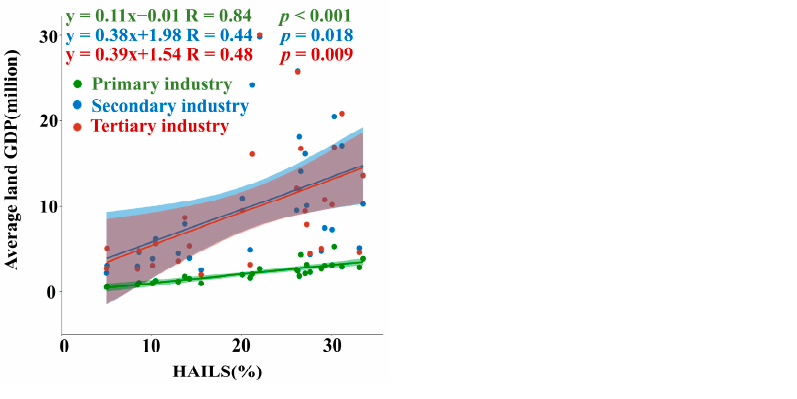
Figure 7. Correlation between average land GDP of primary industry, secondary industry, as well as tertiary industry and the HAILS without Hefei and